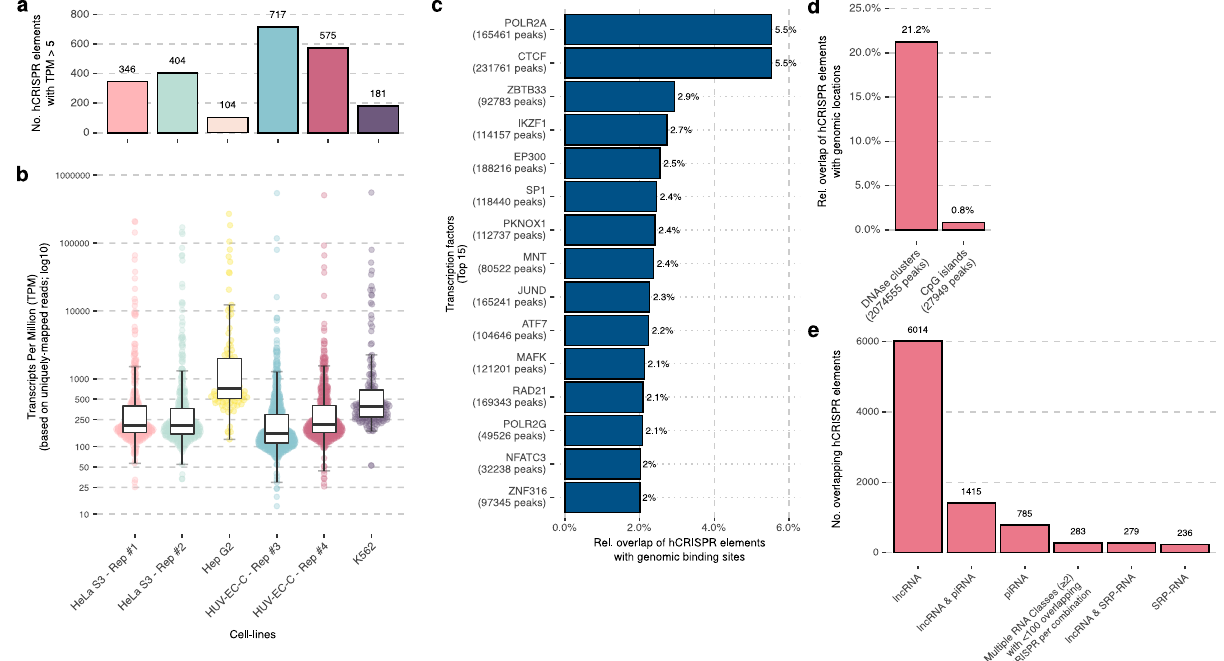
Fig. 3 A subset of the hCRISPRs is actively transcribed in human cell lines and reside within TFBS. a Number of hCRISPRs, with ≥ 5 TPM in four distinct RNA-sequenced human cell lines (HeLa S3 and HUVEC-C both have two replicates). b Boxplots representing the TPM of the hCRISPRs in four distinct RNA-sequenced human cell lines (HeLa S3 and HUVEC-C both have two replicates); median, Q1 and Q3 are highlighted with a bold black line and error bars, respectively. The y -axis is displayed in log 10 -scale. c Overlap of the hCRISPRs with TFBS of 161 transcription factors from ENCODE. Overlap was based on a minimum of fi ve base pairs between hCRISPR foci and binding site foci; the 15 most-overlapped TFBS with the hCRISPRs are shown. The y -axis depicts relative frequencies (number of overlaps divided by total number of hCRISPRs). d Overlap of the hCRISPRs with DNase I clusters from 125 cell types (right) and CpG islands (left) was based on a minimum of fi ve base pairs. e Overlap of the hCRISPRs with known annotations of small RNA from DASHR 2.0, piRBase, and RNAcentral